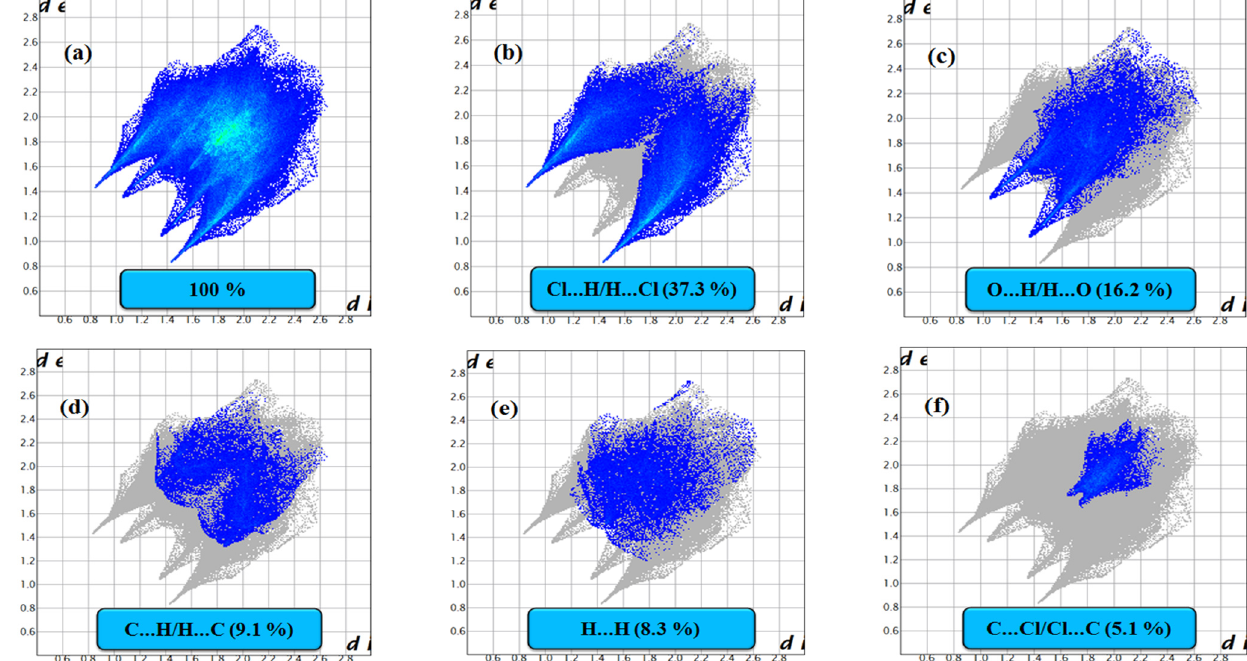
Figure 6. The 2D fingerprints plot of the intermolecular contacts presents in (C 7 H 6 N 3 O 2 ) 2 [ZnCl 4 ]: ( a ) 100%, ( b ) Cl…H/H…Cl contacts, ( c ) O…H/H…O contacts, ( d ) C…H/H…C contacts, ( e ) H…H contacts and ( f ) C…Cl/Cl…C